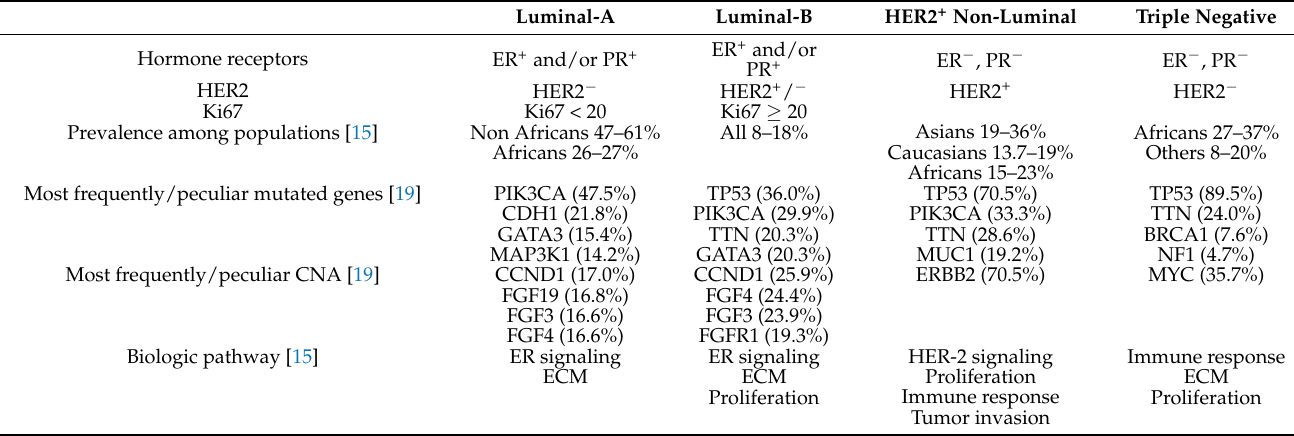
Table 1. Different epidemiological, phenotypical and genetic characteristics among BC